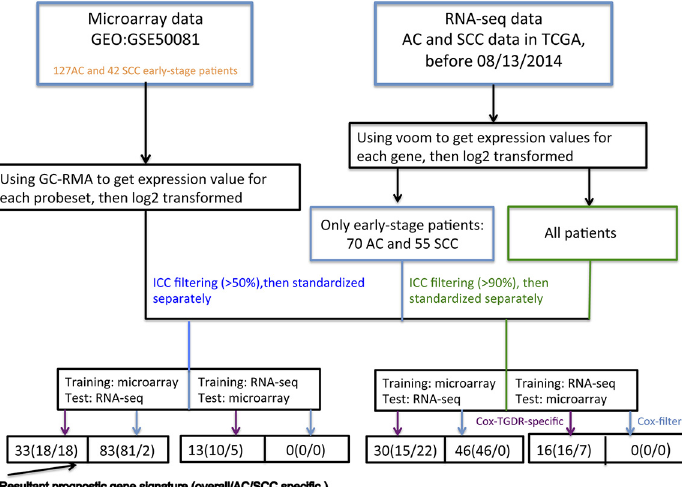
Fig 1. Study schema. A graphical illustration showed how Cox-TGDR-specific and Cox-filter were applied to select relevant subtype-specific prognostic genes for AC and SCC lung cancer.